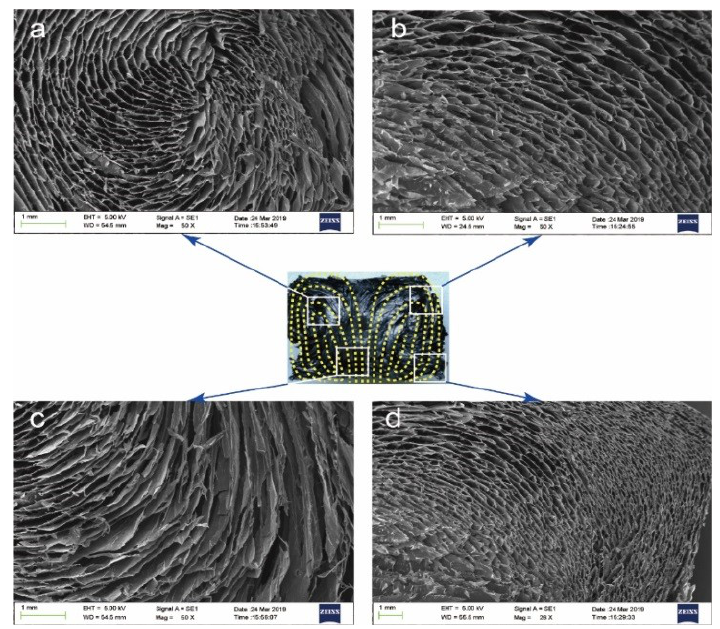
Figure 2. Scanning electron microscopy (SEM) images of di ff erent heat flow locations. ( a – d ) are electron microscope images of di ff erent positions in the longitudinal section of AGA.